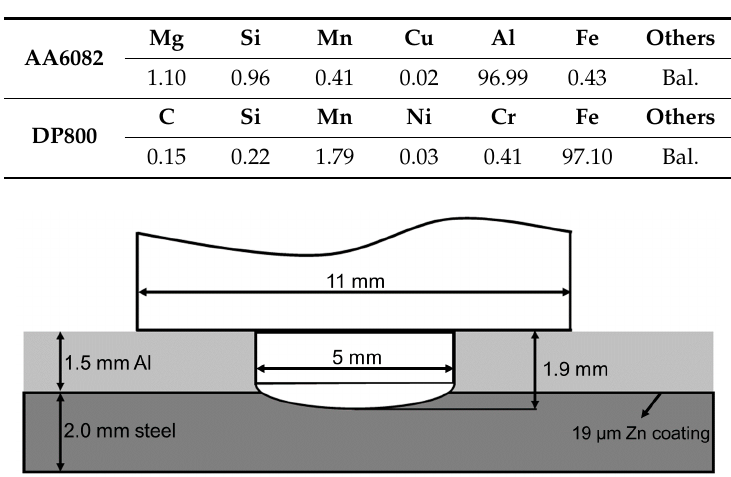
Figure 1. Schematic illustration of the welding setup and details of the tool and materials.